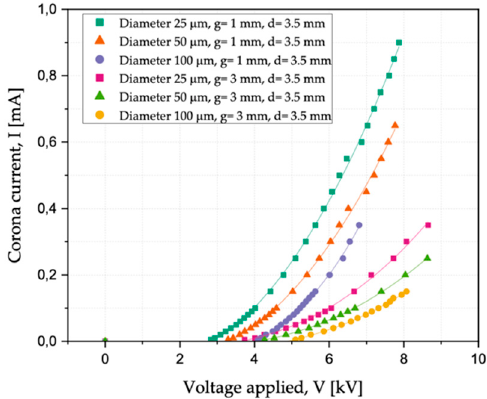
Figure 6. CVCCs by positive corona discharge in atmospheric air for the EMBID configuration with various emitter filament dimensions (25, 50 and 100 μ m).